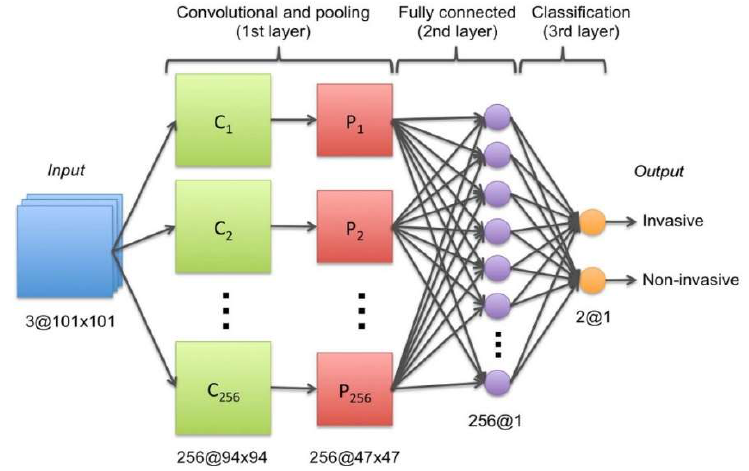
Figure 1. ConvNet architecture used to determine the state of the cancer (invasive or non-invasive) [5].